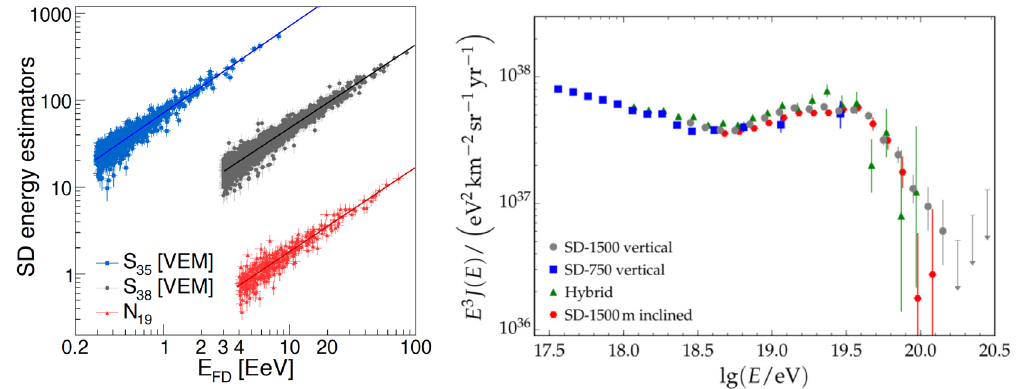
Figure 1. Left: Energy calibration of the surface detector. The shower size measured for ‘vertical’ events with the SD-1500 ( S 38 ) and SD-750 ( S 35 ) array and for inclined showers ( N 19 ) is shown as a function of the energy measured with the fluorescence telescopes ( E FD ). Right: The energy spectra obtained with the four spectrum components. The systematic uncertainty on the energy scale, common to all of them, is 14%